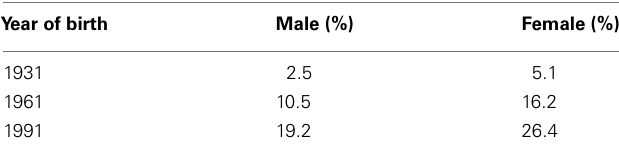
Table 1 | Chance of living to age 100 according to birth year and sex (directly from with